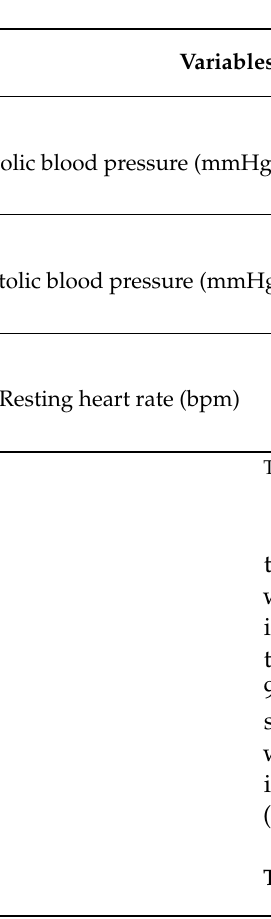
Table 4. Changes in cardiovascular function variables after 24 weeks of non-face-to-face exercise.